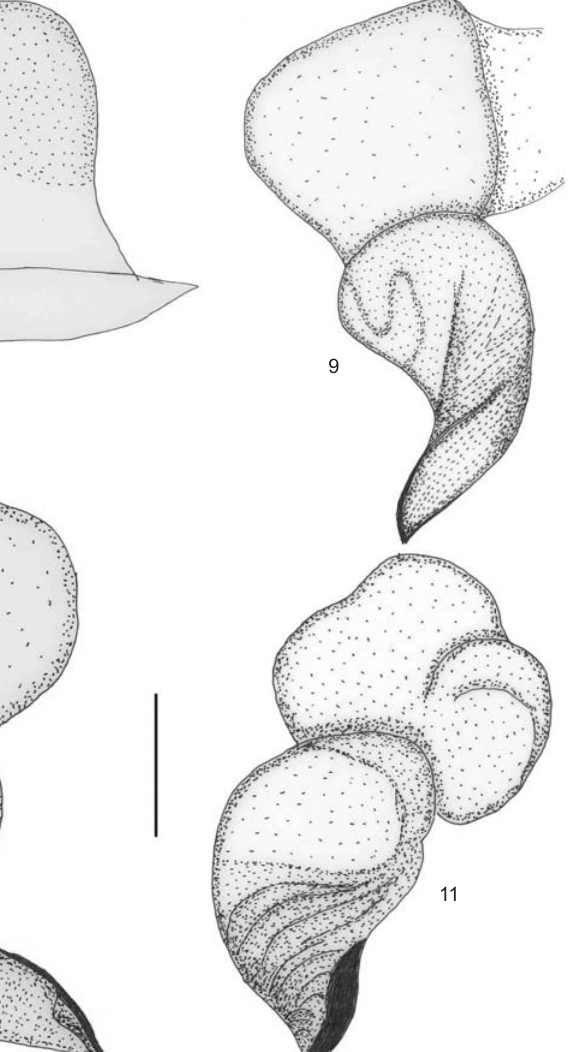
2.04 long, 0.74 wide, 0.85 apart; PLS, 3.31 basal, 1.56 middle, 2.47, distal; midwidths 1.35, 1.09, 0.85, respectively and 1.30 apart. Morphometry of leg and palp given in Table 2. Colour in life (Image 3): Carapace reddish-brown overall with two prominent (after preservation) black bands emerging from fovea running across caput, entire surface covered with short black and golden hair. Abdomen black dorsally, yellowish on ventral and ventrolateral side covered with short and long black hair. Legs overall covered with long as well as short brown hair. Carapace: Fovea deep, procurved. Length